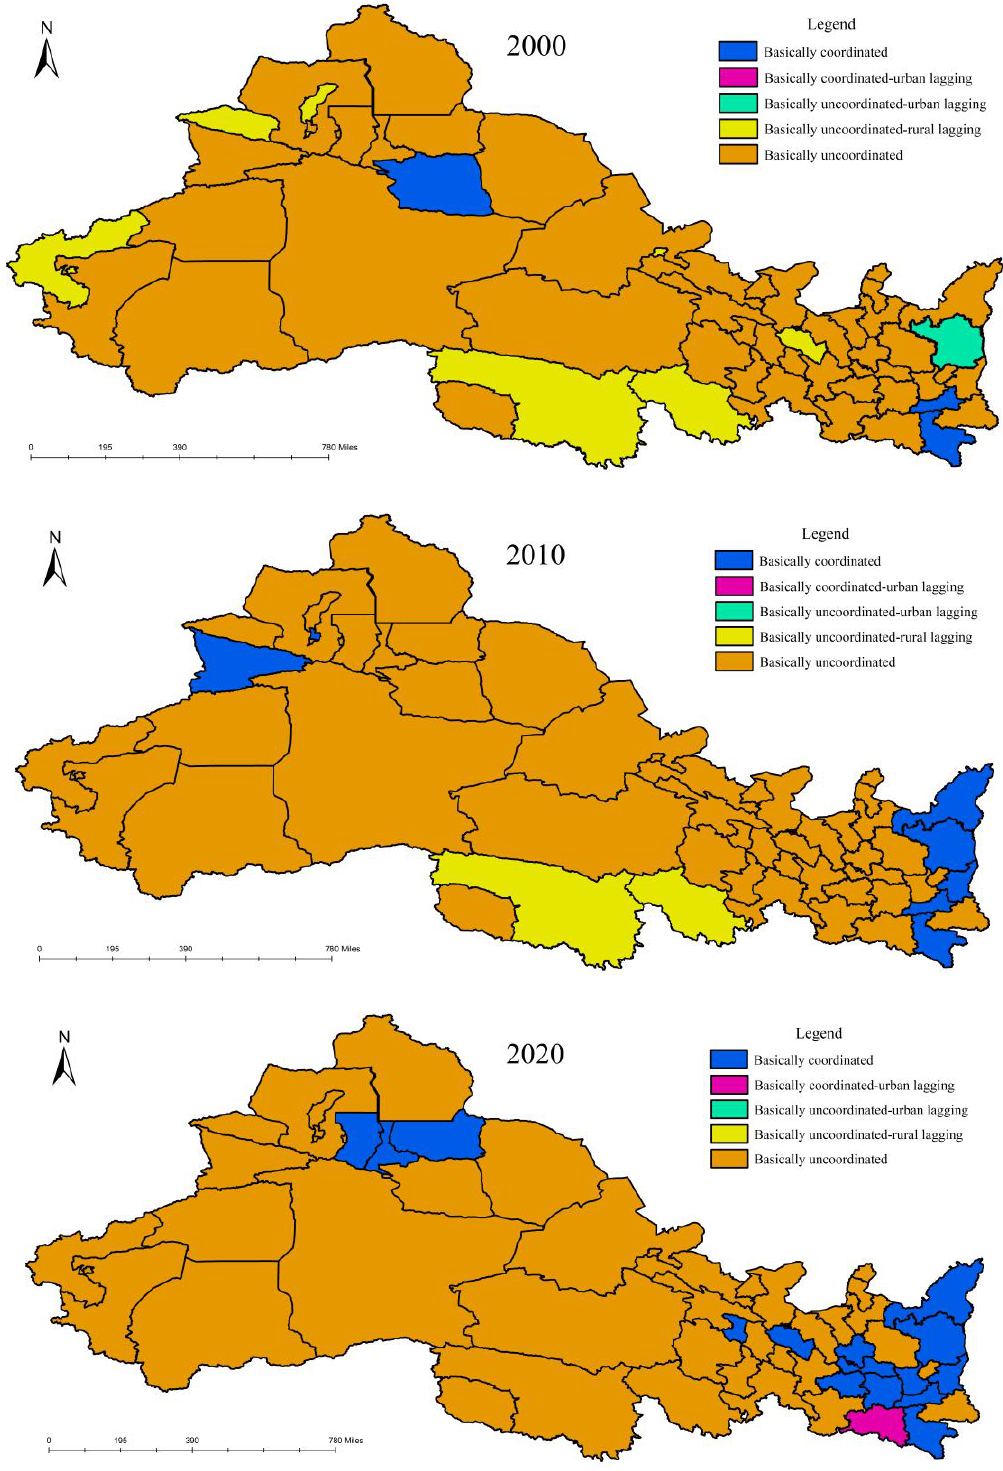
Figure 4. Coupling coordination level between urban and rural water poverty in northwest China from 2000 to 2020.